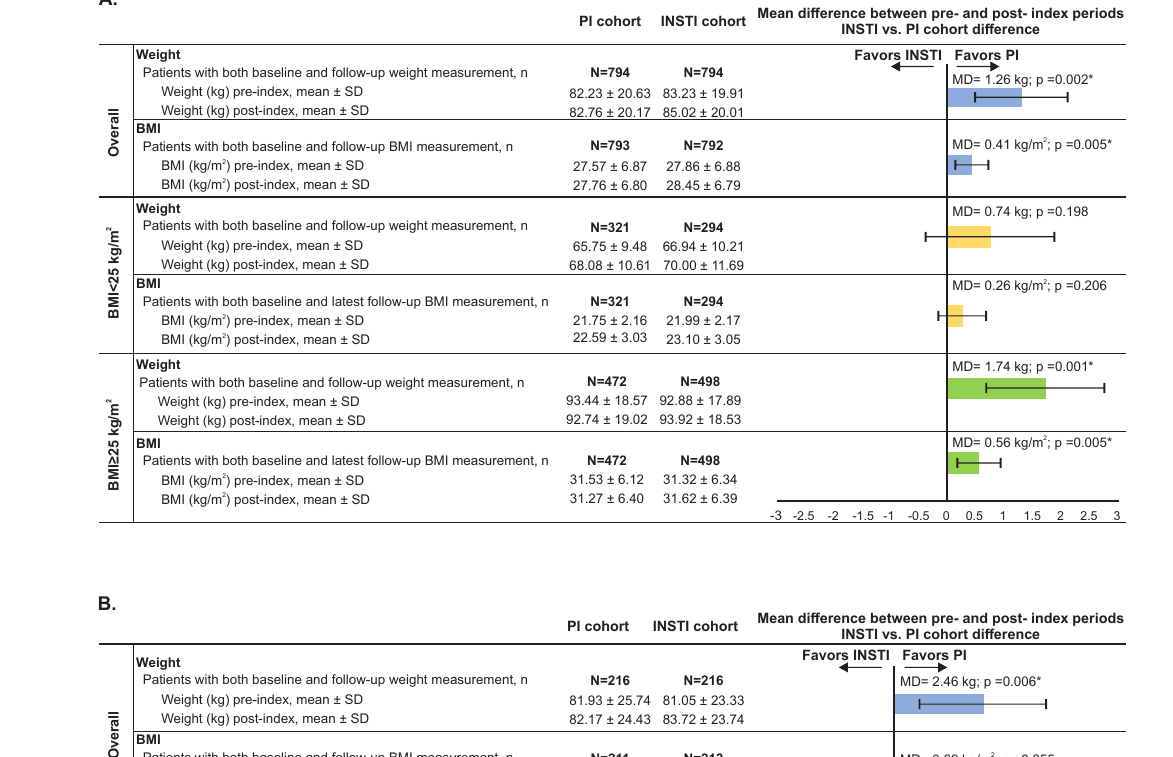
Mean difference between pre- and post- index periods INSTI vs. PI cohort differenceINSTI cohortPI cohort